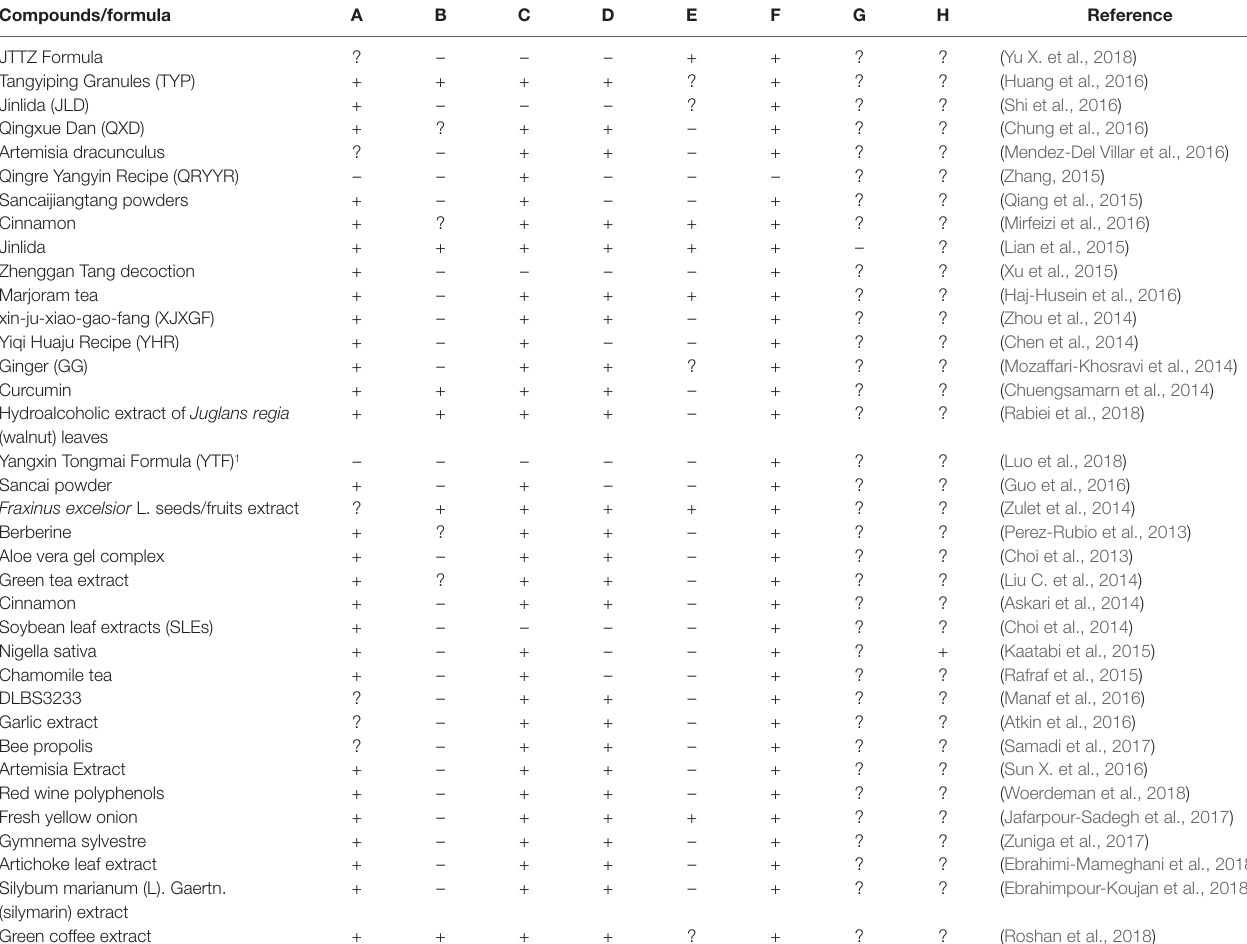
TABLE 3 | Risk of bias of the clinical trials.